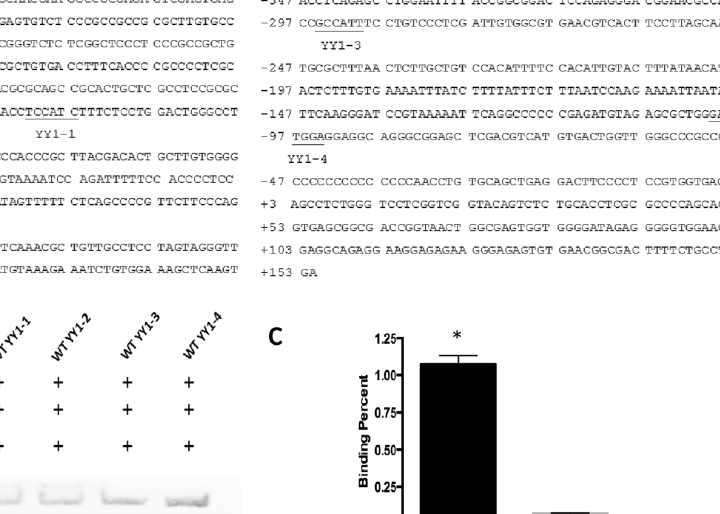
Expression level of ATP6V1A is positively correlated with expression level of YY1 in gastric cancer. Through the analysis of YY1 and ATP6V1A mRNA expression in GC tissues of 369 individuals in the TCGA